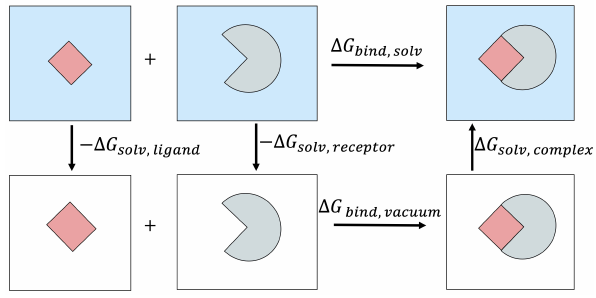
Figure 3. The thermodynamic cycle used to estimate the binding free energy of a protein–ligand complex in the